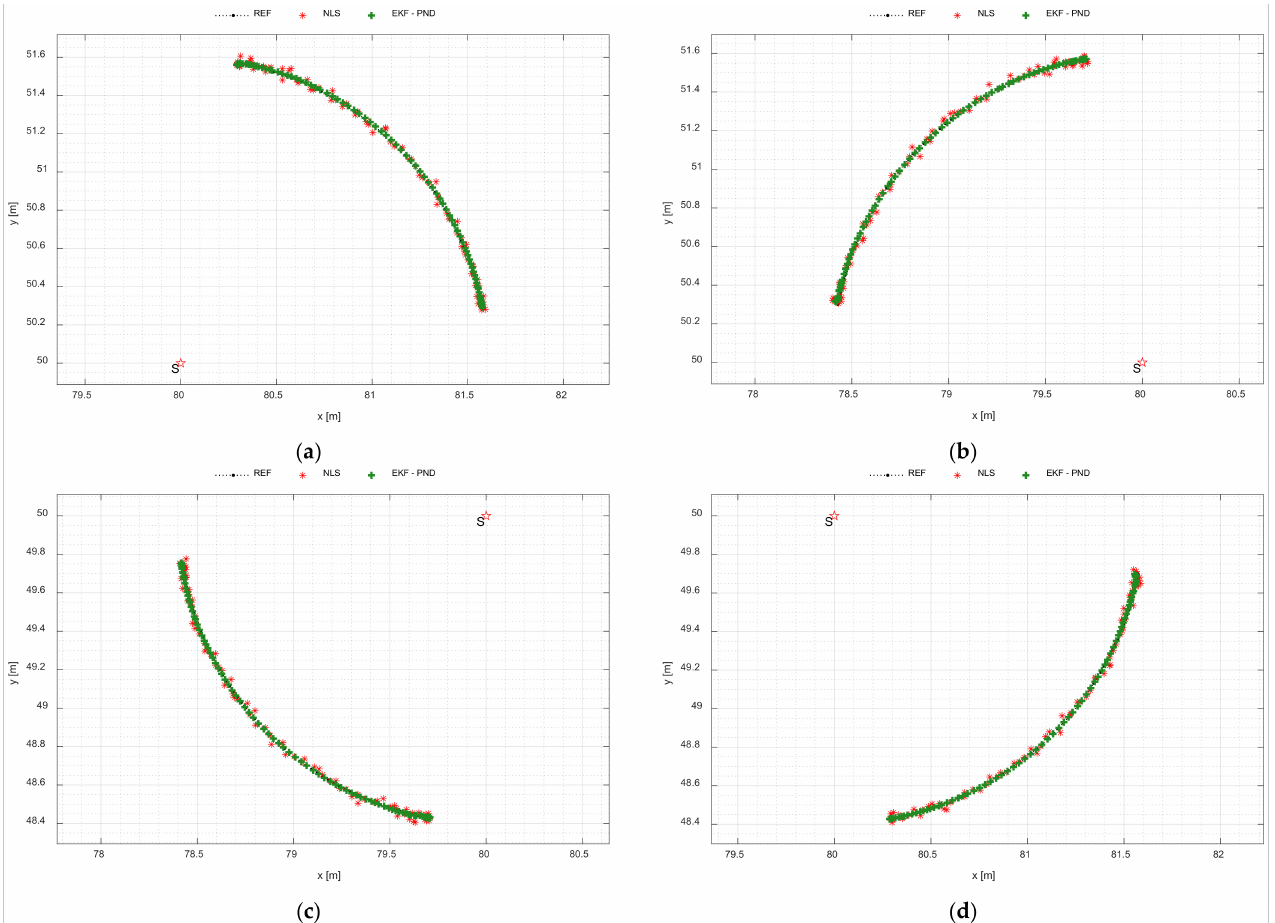
Figure 11. Estimated antenna positions with EKF-PND and NLS, for various orientations of the central axis of the scanning section: ( a ) 45 ◦ ; ( b ) 135 ◦ ; ( c ) 225 ◦ ; ( d ) 315 ◦ .